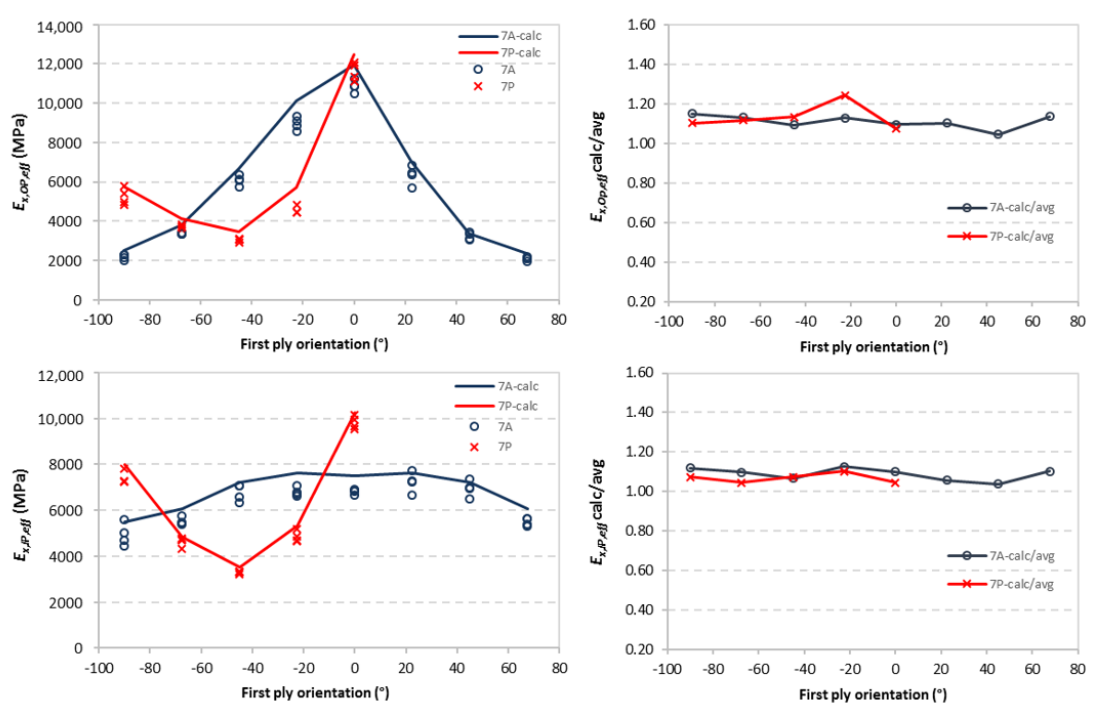
Figure 6. Calculated and measured e ff ective modulus of elasticity and shear modulus for 11-layer samples for di ff erent combinations of layer orientations. The points represent single values obtained from the natural frequencies of flexural, torsional and longitudinal vibrations. Solid lines represent calculated values using the laminate theory.